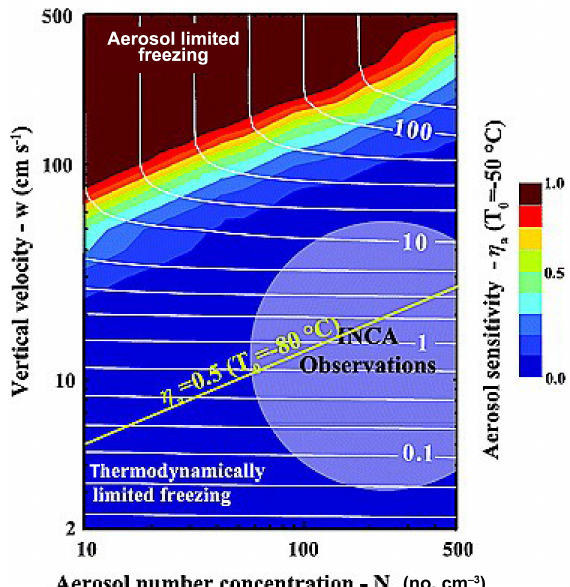
Figure 2. Aerosol sensitivity (derivative of the logarithm of ice crystal number concentration with respect to the logarithm of aerosol concentration) and ice number concentration (contoured) as functions of vertical velocity and aerosol number concentration for homogeneous freezing, from Kay and Wood (2008). Shaded aerosol sensitivities are for a parcel lifted at − 50 ◦ C and 250hPa, with the line indicating an aerosol sensitivity of 0.5 at − 80 ◦ C and 100hPa. Observations (10–90 percentiles) from the INCA (INter- hemispheric differences in Cirrus properties from Anthropogenic emissions) field campaign fall within the light